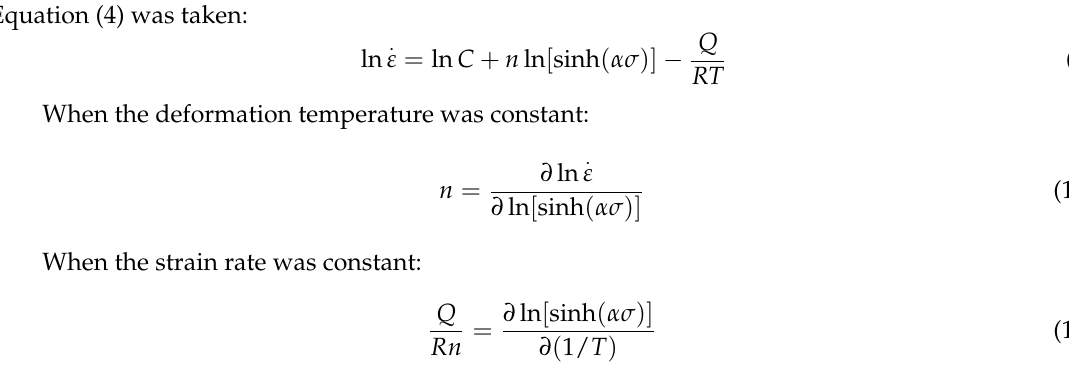
Figure 3. The linear relationships of ( a ) ln ε and ln σ ; ( b ) ln ε and σ .